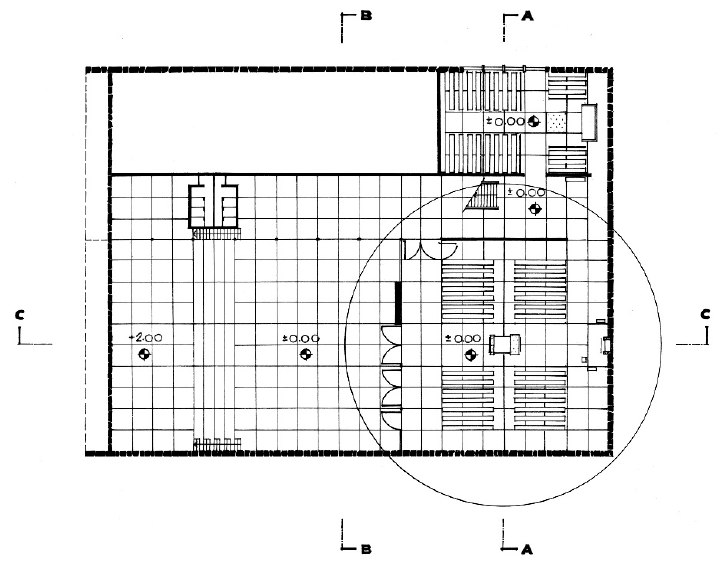
Figure 1. The Central Synagogue, Nazareth Illit, architect Nahum Zolotov, 1968. Plan. Courtesy of the